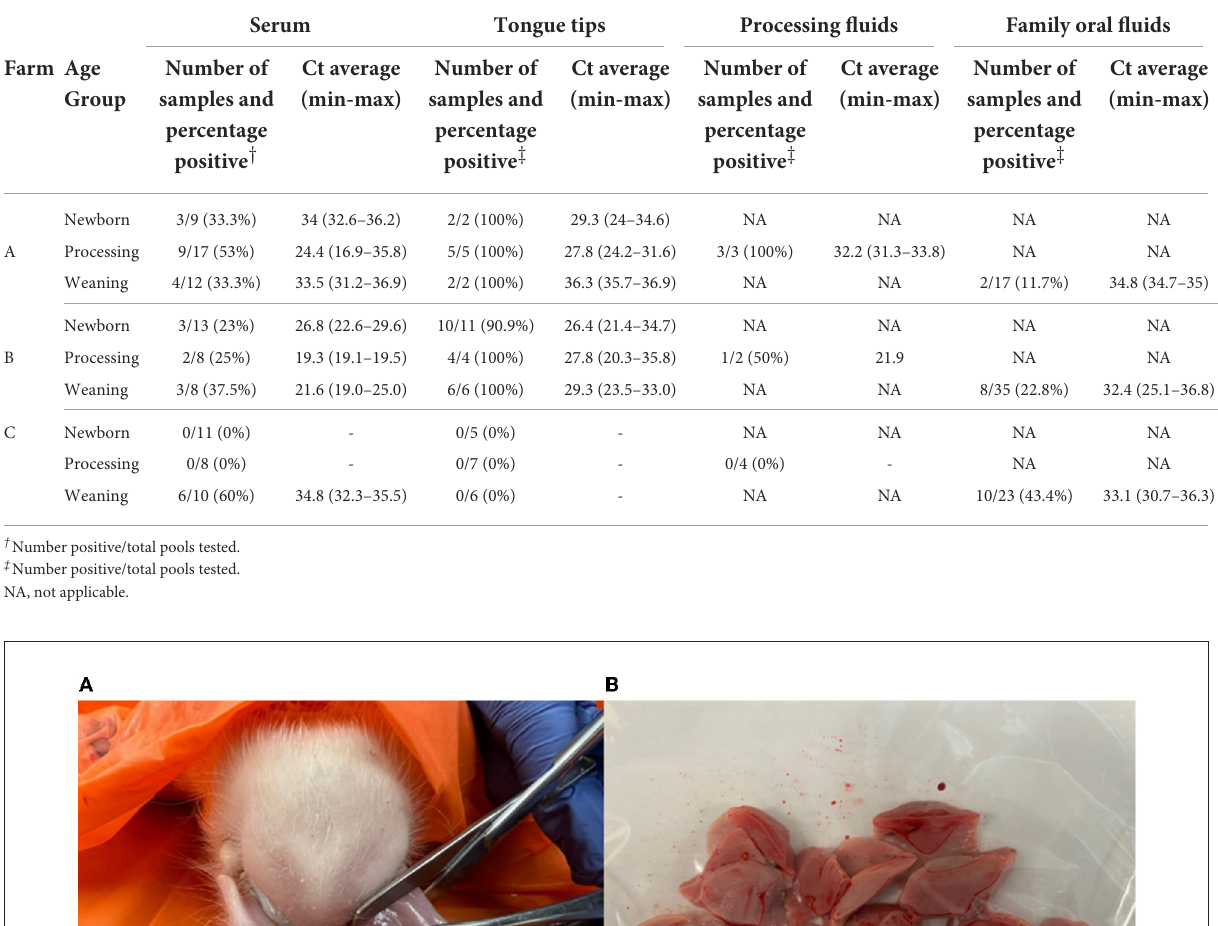
TABLE 1 Porcine reproductive and respiratory syndrome virus RNA detection by sample type and age group in three commercial breed-to-wean farms.